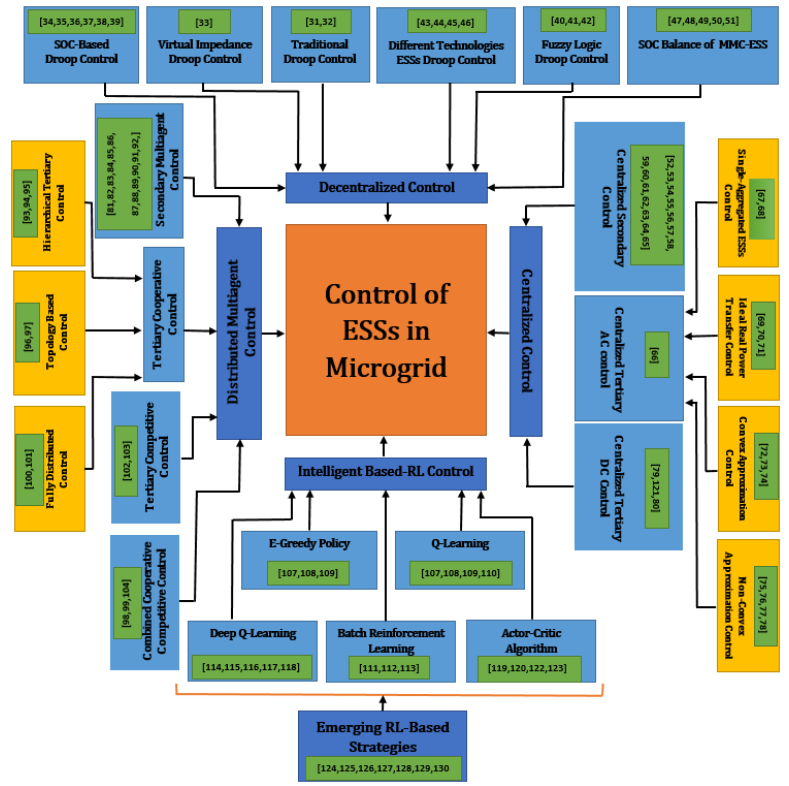
Figure 2. Control strategies of ESS in microgrid with the relevant reviewed research works.